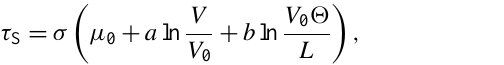
Fig. 11. Shear and normal stresses of TPV15 recorded on the main fault at 2 km along-strike from the junction and 7 . 5 km depth. Differences are due to differences in fault geometry at the junction as discussed in the main text. ADER-DG solutions are shown in black (with gap) and blue (without gap), the FEM comparison solutions in red ( 50 m discretization) and green ( 100 m discretization).